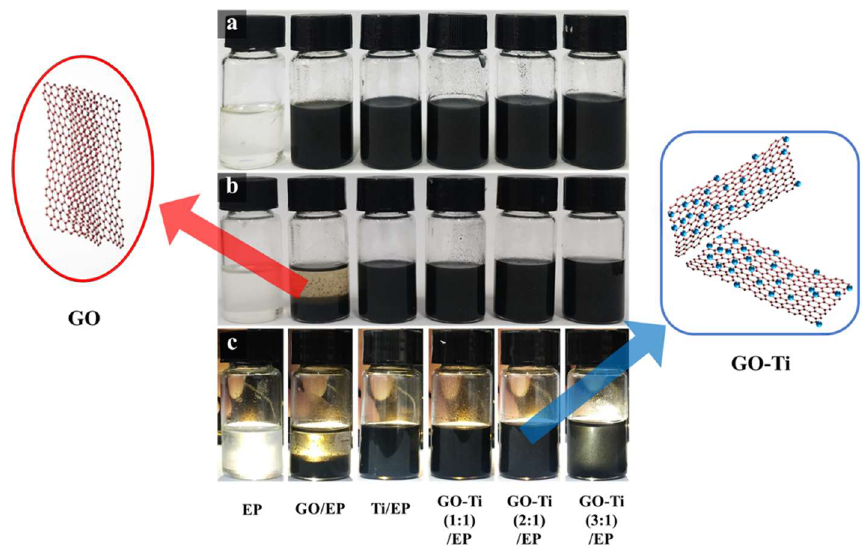
Figure 6. Settlement experiment of di ff erent composite coatings at di ff erent times: ( a ) 0 days, ( b ) 14 days, and ( c ) 70 days.